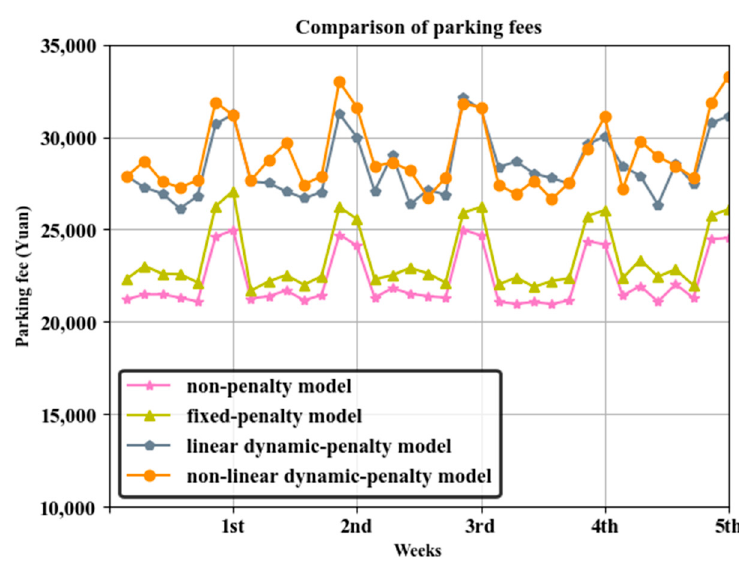
Figure 9. Comparison of parking fees.